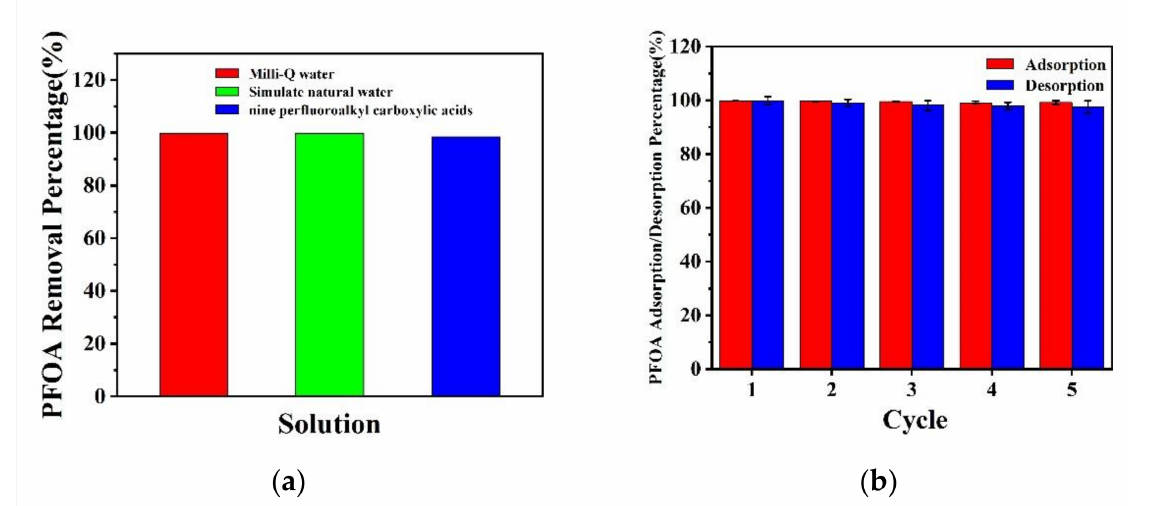
Figure 6. ( a ) Kinetics of PFOA adsorption by POP-4F ([PFOA] 0 = 1 mg L − 1 ; [POP-4F] = 200 mg L − 1 ) at 25 ◦ C; ( b ) Regeneration of POP-4F by MeOH washing. Error bars: standard deviation of three